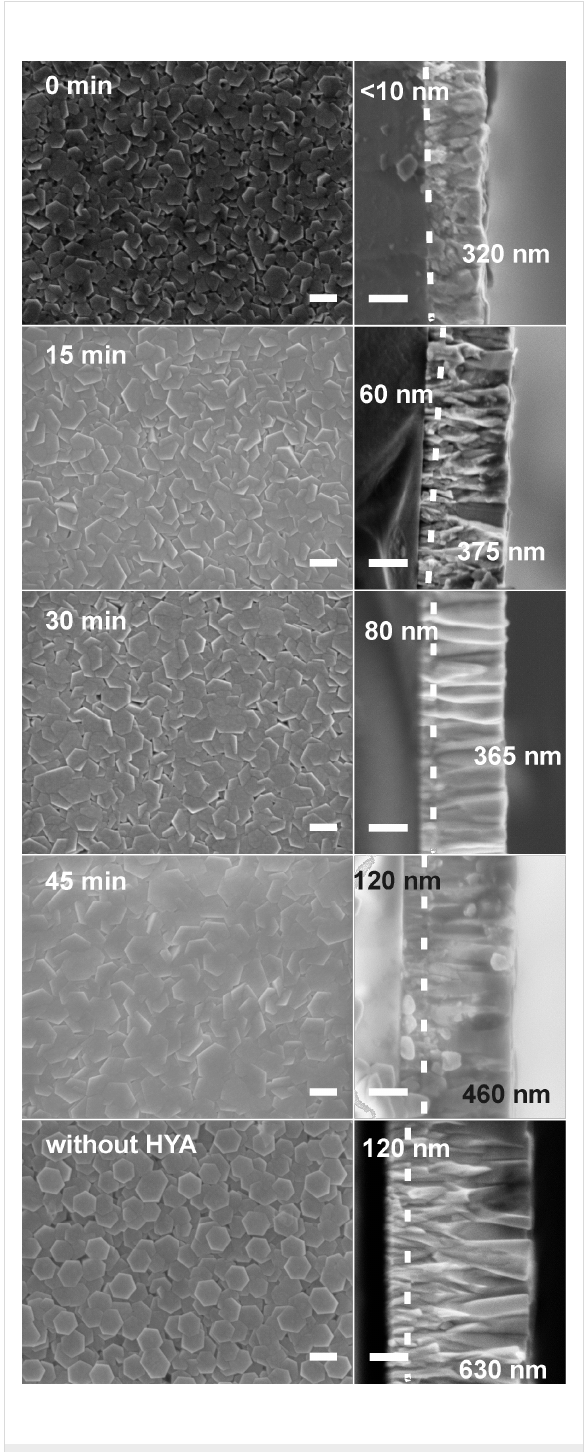
Figure 6: SEM micrographs in plan view (left) and corresponding cross sections (right) of ZnO films after the second CBD step. The films were prepared both without HYA and with different addition times of HYA during the first CBD step (scale bars: 200 nm). The dotted lines indicate the interface between the ZnO grown in the first and the second CBD steps. The values in nm correspond to the film thick- nesses of the ZnO grown within the first (to the left of the dotted line) and the second CBD (to the right of the dotted line) steps,